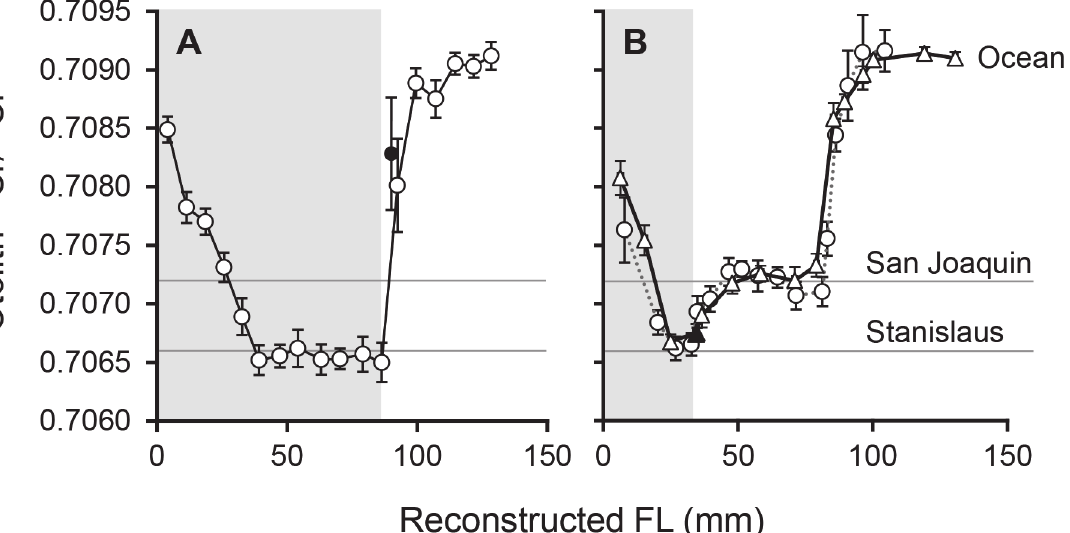
Fig 3. Otolith 87 Sr/ 86 Sr reconstructions of a smolt and fry outmigrant. Otolith 87 Sr/ 86 Sr profiles against back-calculated FL for two adult Chinook salmon that returned to the Stanislaus River having outmigrated as (A) a smolt and (B) a fry. The shaded box indicates the time spent rearing in the natal river. The fry outmigrant reared for several weeks downstream in the San Joaquin River before migrating out to the ocean, as indicated by both the left (triangles, solid line) and right (circles, dashed line) otolith (back-calculated FL = 33.3mm vs . 34.9mm). Mean 87 Sr/ 86 Sr signatures for the Stanislaus and San Joaquin Rivers, and modern-day ocean are displayed. Black filled symbols indicate ‘ re-spots ’ carried out to improve sampling resolution. Error bars = 2SE.